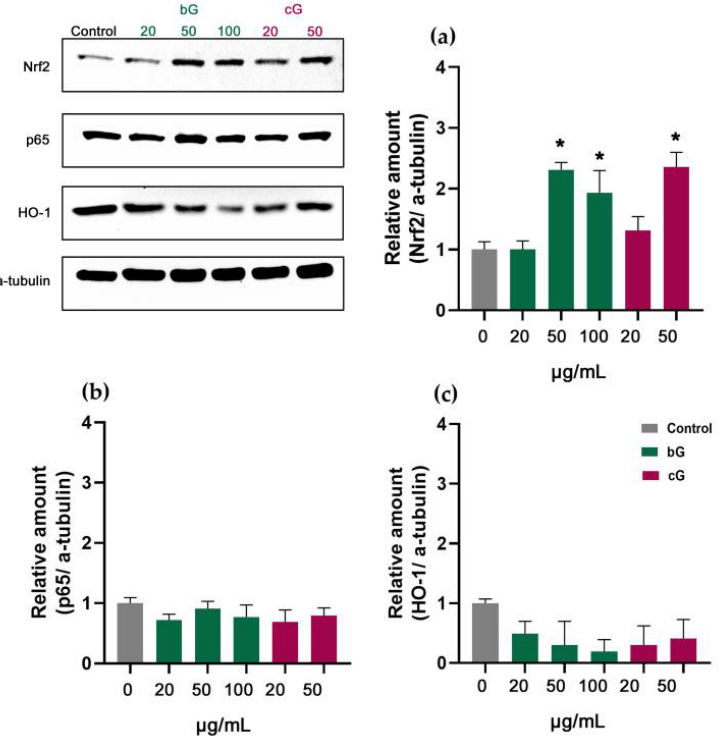
cells compared to the control (Figure 10c). Moreover, cG induced a significant increase in